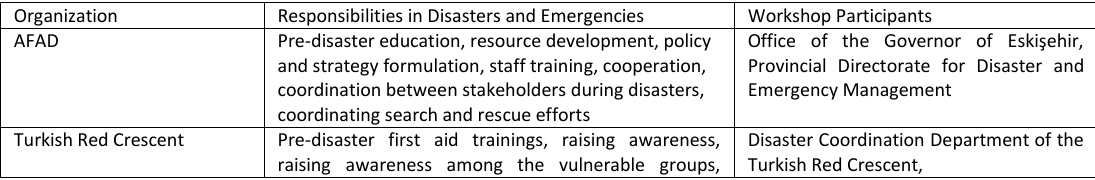
Table 1 Participants of the workshop and their roles & responsibilities in disaster management